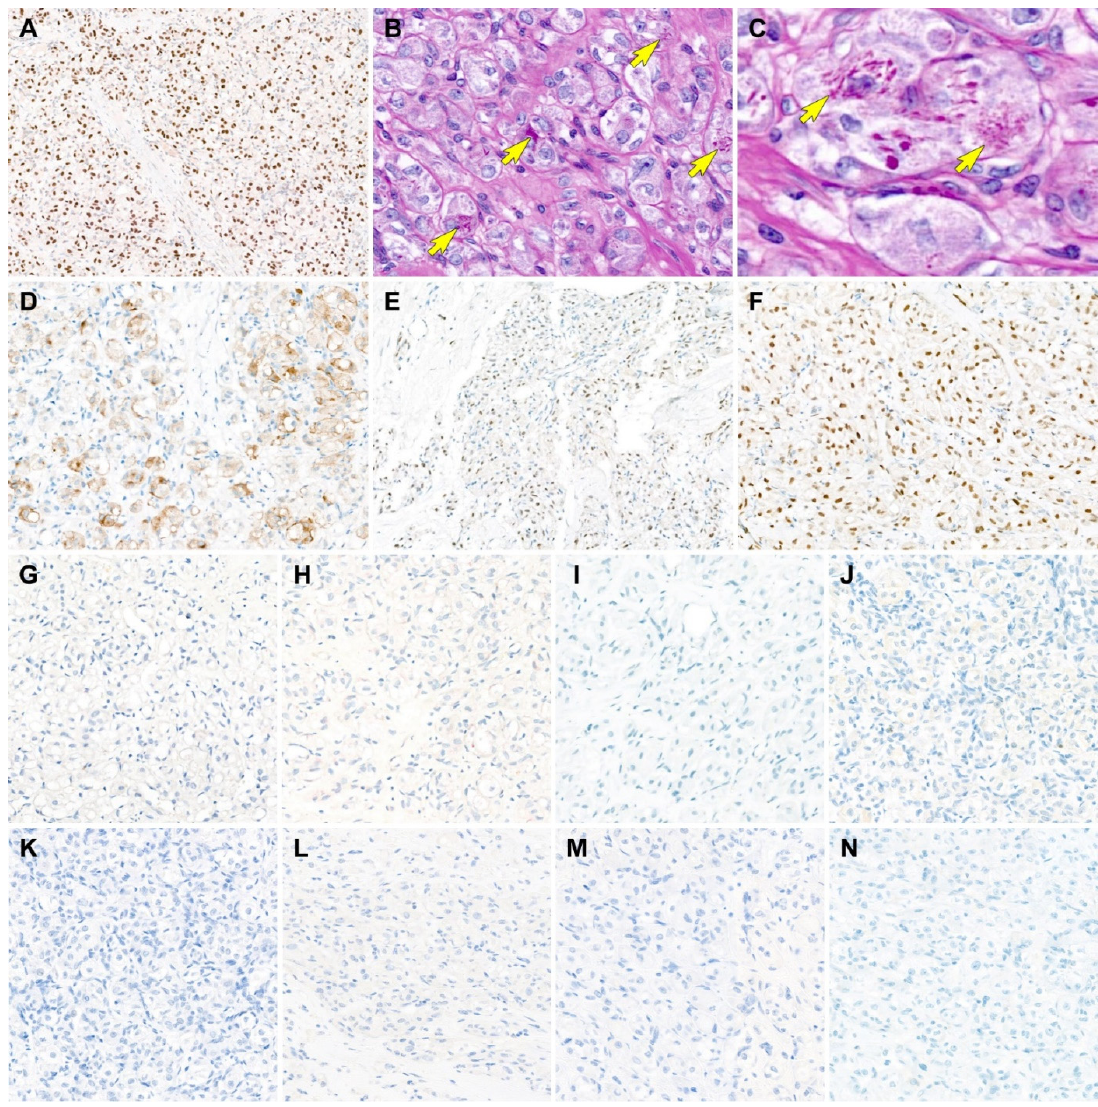
Figure 3. Results of immunostaining and special staining (case 1). ( A ) The tumor cells show uniform and strong nuclear immunoreactivity for transcription factor E3 (TFE3), a surrogate marker for ASPS chromosome region, candidate 1 ( ASPSCR1 )– TFE3 fusion. ( B , C ) Periodic acid-Schiff with diastase digestion staining highlights the aggregates of eosinophilic intracytoplasmic rod-shaped crystalloids, which locate closely adjacent to the tumor cell nuclei (yellow arrows). ( D – F ) The tumor cells express ( D ) CD10, ( E ) estrogen receptor, and ( F ) progesterone receptor. ( G – M ) In contrast, the tumor cells are negative for ( G ) human melanoma black 45, ( H ) melan-A, ( I ) desmin, ( J ) S100, ( K ) pan-cytokeratin, ( L ) paired box 8, and ( M ) synaptophysin, excluding the possibility of TFE3 translocation-associated perivascular epithelioid cell tumor, clear cell sarcoma, granular cell tumor, metastatic renal cell carcinoma, and paraganglioma. ( N ) MET expression is absent in the tumor cells. Original magnification: ( A ) 60 × ; ( B ) 400 × ; ( C ) 600 × ; ( D ) 200 × ; ( E ) 40 × ; ( F – N ) 200 ×